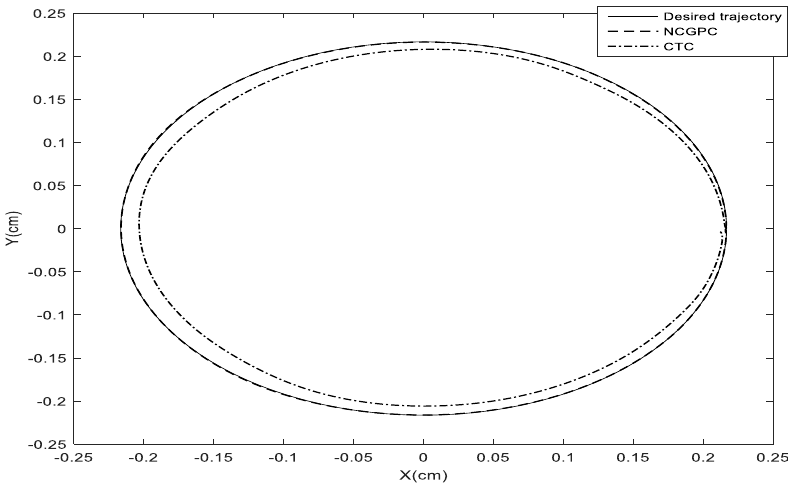
Figure 14. Effect of model uncertainties on both CTC and NCGPC tracking performance.